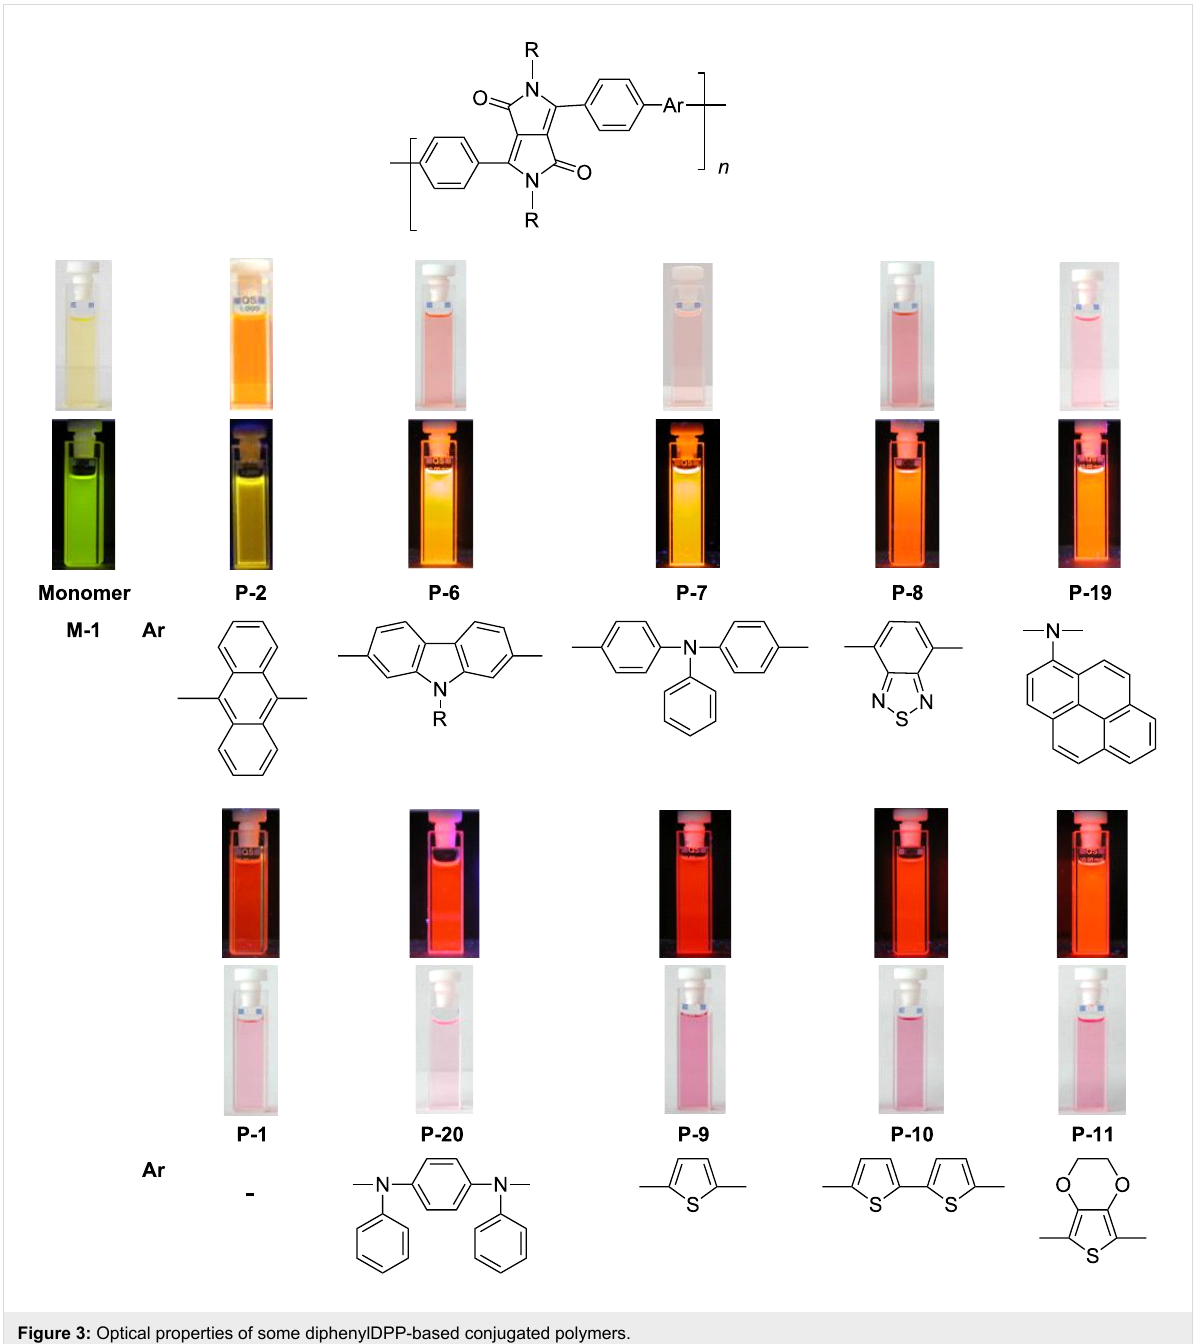
Figure 3: Optical properties of some diphenylDPP-based conjugated